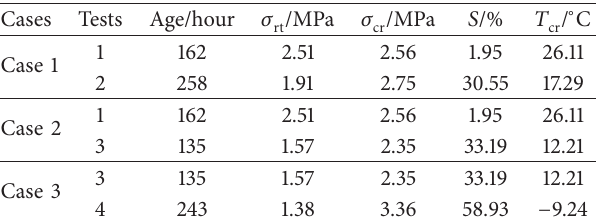
Table 3: Dimension of the specimen in the TSTM (m). Table 4: Results and crack indicators of